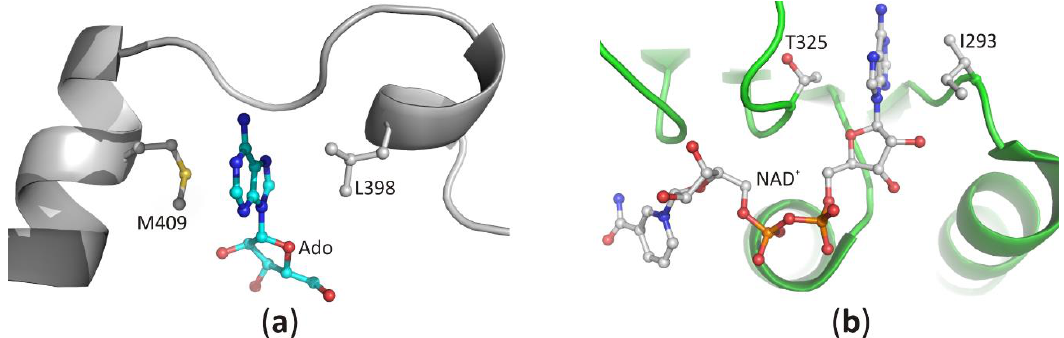
Figure 6. The recognition mode of the purine ring in ( a ) the substrate-binding domain and ( b ) the cofactor-binding domain of plant SAHase from Lupinus luteus .